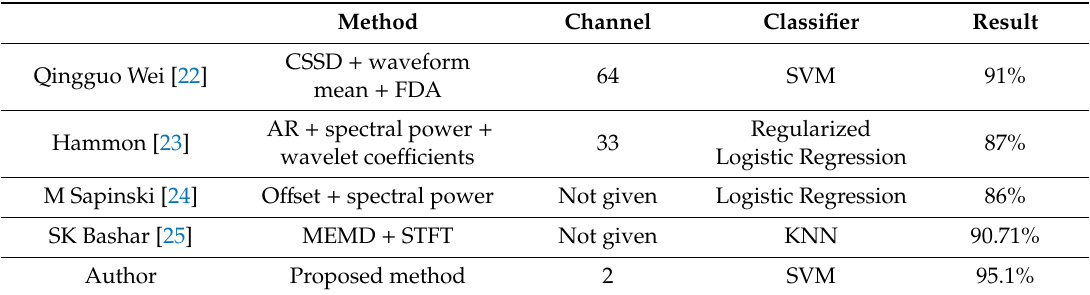
Table 2. Comparison of brain–computer interface (BCI) competition results and the results of this